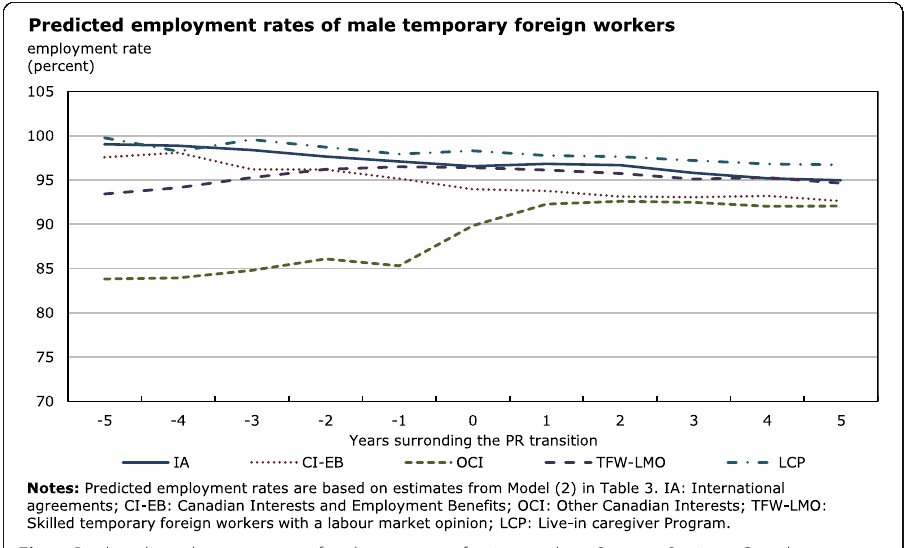
Fig. 5 Predicted employment rates of male temporary foreign workers. Sources: Statistics Canada, Temporary Residents file, Immigrant Landing file and Canadian Employer-Employee Dynamics